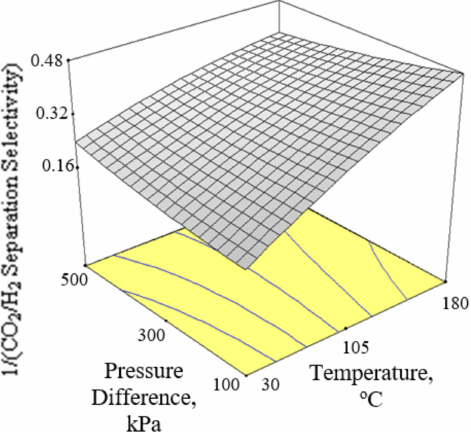
Figure 6. Effect of interaction between temperature and pressure difference on the 1/(CO 2 /H 2 separation selectivity) at 27.5% CO 2 in the feed.